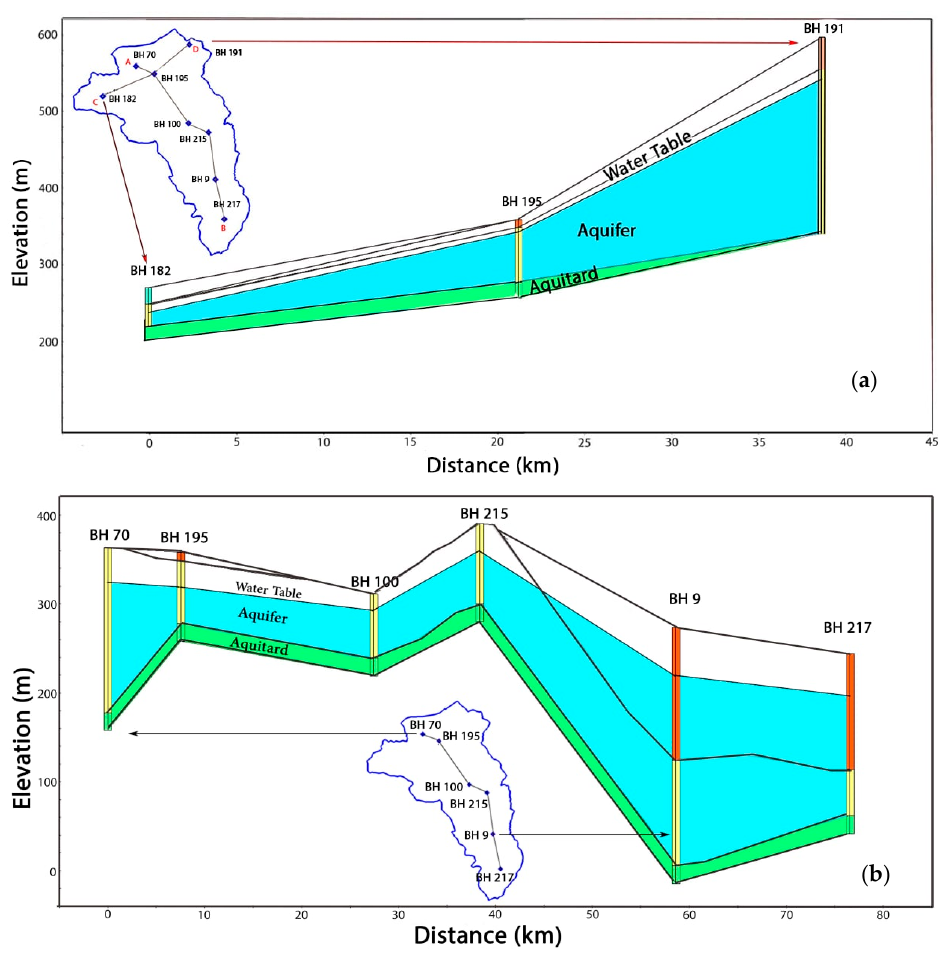
Figure 5. Selected cross sections in the study area ( a ) from NW–SE, and ( b ) from NE–SW.